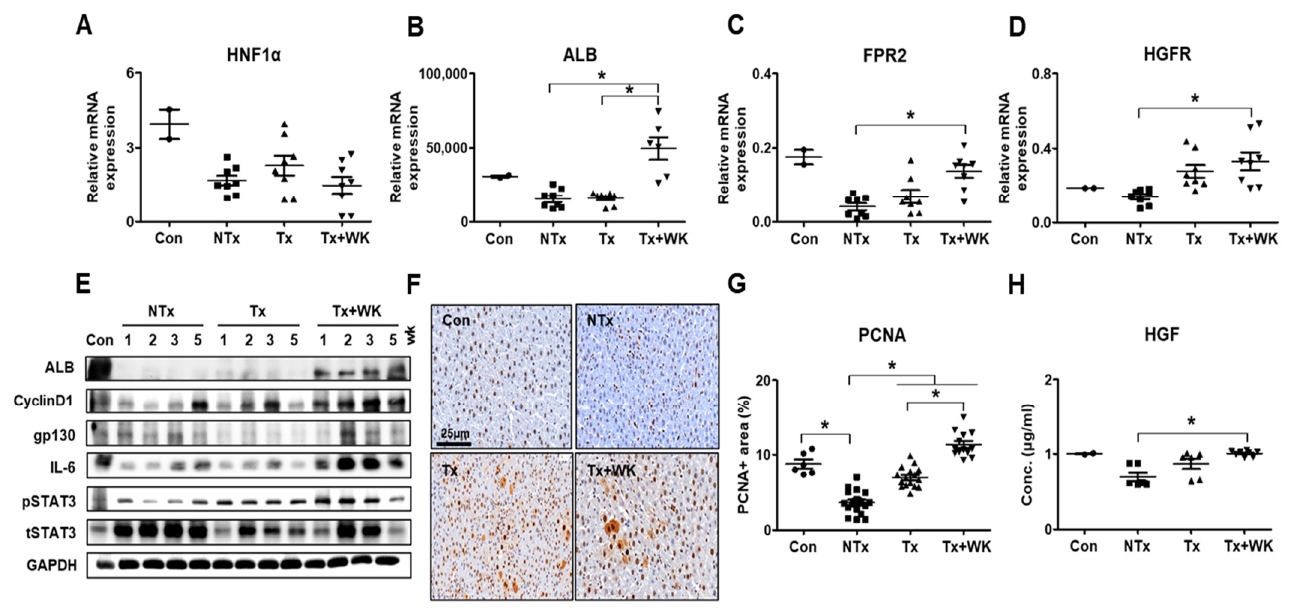
Figure 6. PD-MSCs combined with WKYMVm enhance hepatic regeneration in the BDL rat model. mRNA expression of HNF1 α ( A ), ALB ( B ), FPR2 ( C ), and HGFR ( D ) in BDL rat liver shown by qRT-PCR. ( E ) Protein levels of ALB, cyclin D1, gp130, IL-6, p/tSTAT3, and GAPDH in BDL rat livers shown by Western blots. ( F ) Expression of PCNA in BDL rat liver shown by immunohistochemistry. Scale bar = 25 μ m. ( G ) Quantification of the PCNA-positive area in BDL rat livers through immunohistochemistry. ( H ) Secreted HGF level in BDL rat serum shown by ELISAs. n = 3 rats per group, mean ± SD, *, p < 0.05 by one-way ANOVA. Con, control; NTx, nontransplantation group; Tx, PD-MSC transplantation group; Tx+WK, PD-MSCs with WKYMVm combined transplantation group; wk, week.